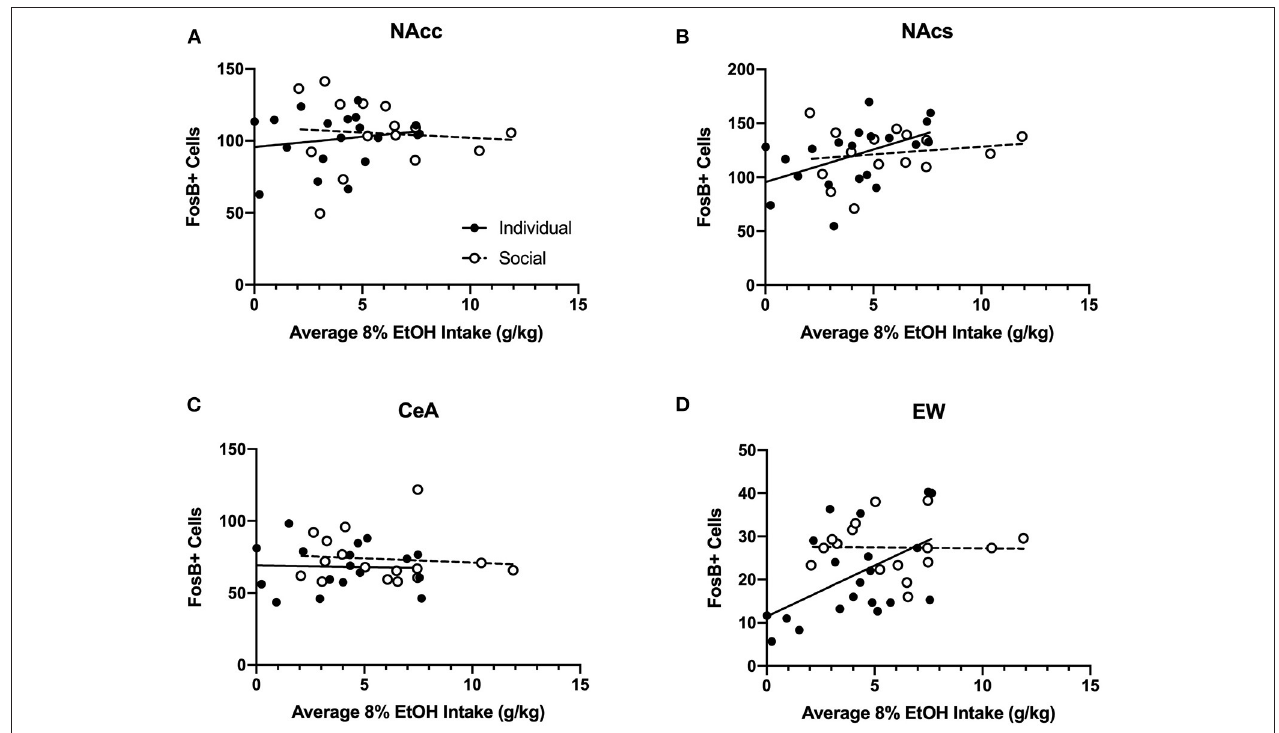
FIGURE 13 | Correlations between average baseline g/kg ethanol intake and FosB-positive cells in various ethanol-responsive brain regions. Ethanol data in g/kg represent average intake across all days of baseline 8% ethanol availability. (A) Intake correlation with FosB-positive cells in the nucleus accumbens core (NAcc). For individually-housed mice, r 2 = 0.03, p = 0.47, n = 20. For socially-housed mice, r 2 = 0.007, p = 0.76, n = 15. (B) Intake correlation with FosB-positive cells in the nucleus accumbens shell (NAcs). For individually-housed mice, r 2 = 0.24, p < 0.05, n = 19. For socially-housed mice, r 2 = 0.03, p = 0.54, n = 15. (C) Intake correlation with FosB- positive cells in the central amygdala (CeA). For individually-housed mice, r 2 = 0.001, p = 0.89, n = 18. For socially-housed mice, r 2 = 0.009, p = 0.72, n = 16. (D) . Intake correlation with FosB- positive cells in the centrally-projecting Edinger-Westphal nucleus (EW). For individually-housed mice, r 2 = 0.27, p < 0.05, n = 20. For socially-housed mice, r 2 = 0.0003, p = 0.95, n =